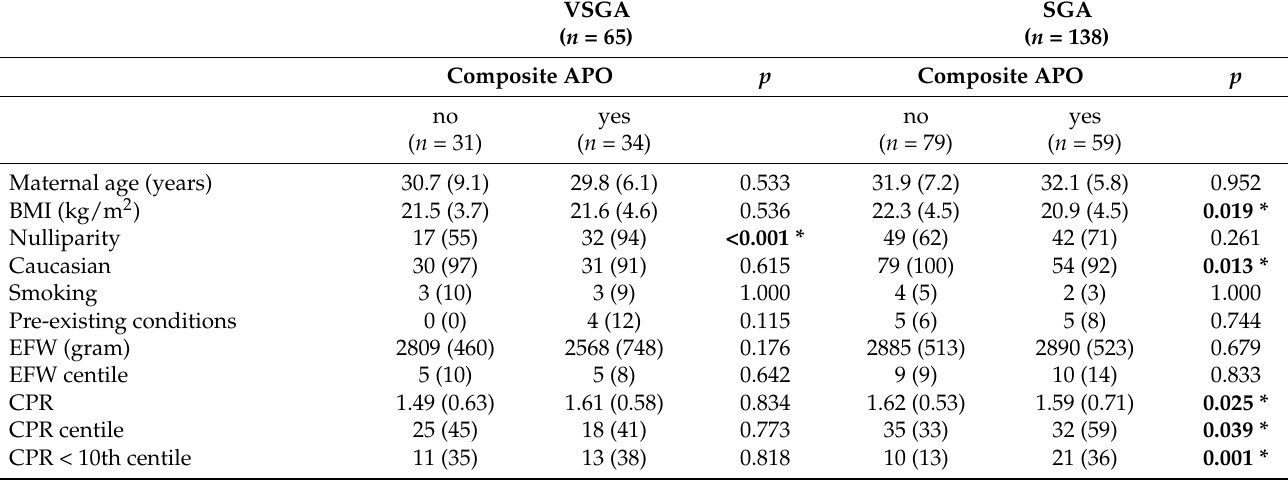
Table 2. Characteristics of the entire study population according to the composite adverse perinatal outcome